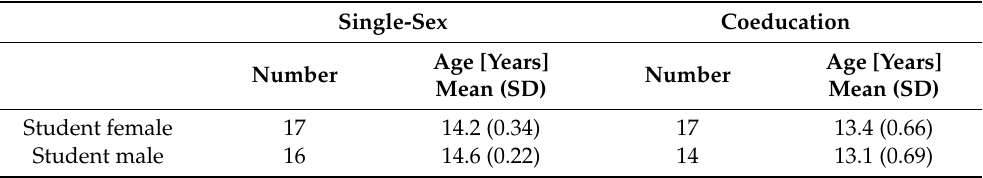
Table 1. Student characteristics divided into physical education settings.